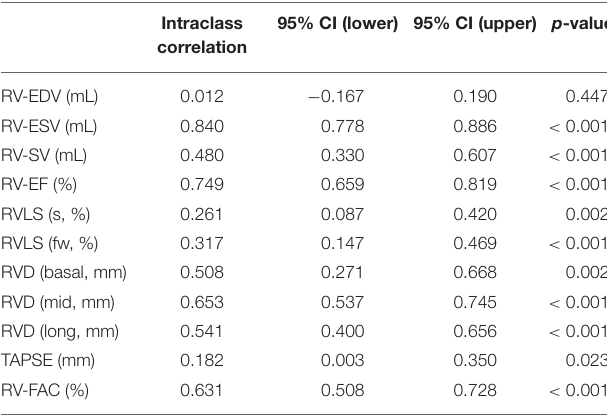
TABLE 2 | Interobserver variability with 4D auto-RVQ in PHTN and Healthy controls. Intraclass correlation